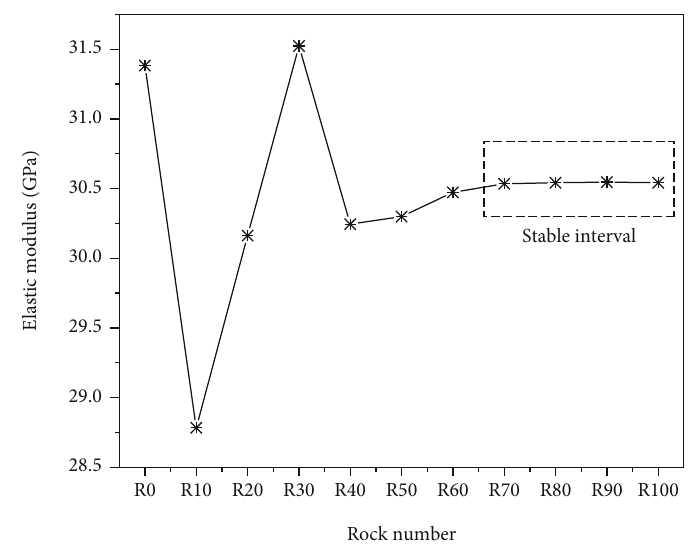
Figure 16: Elastic modulus-CRV